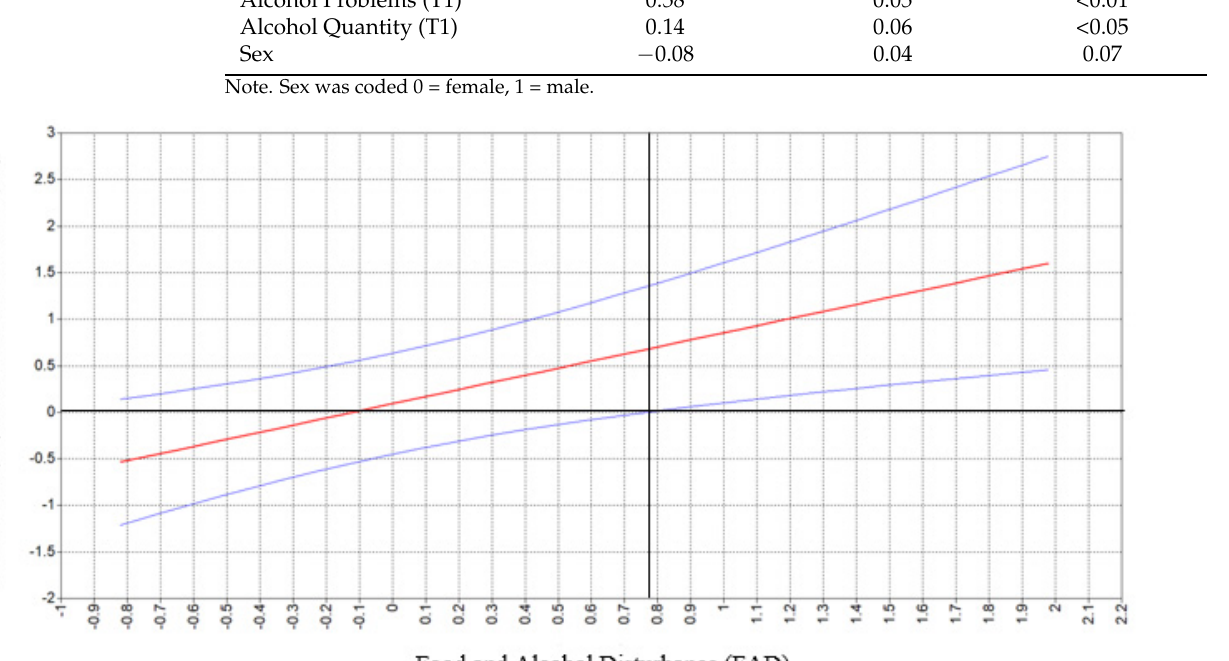
Figure 1. Association of loneliness (T1) and alcohol problems (T2) as a function of FAD among college students who reported binge drinking behavior. Note. The straight (middle, red) line represents the unstandardized adjusted effect of loneliness (T1) on alcohol problems (T2) at different levels of FAD. The curved (blue, top and bottom) lines represent 95% confidence intervals. For college students, who reported FAD ratings at 0.77 standard deviation of sample mean or greater, zero was not included within the confidence intervals of the association of loneliness (T1) and alcohol-related problems (T2), such that loneliness and alcohol-related problems were significantly related in a positive direction at higher levels of FAD (right upper quadrant of this